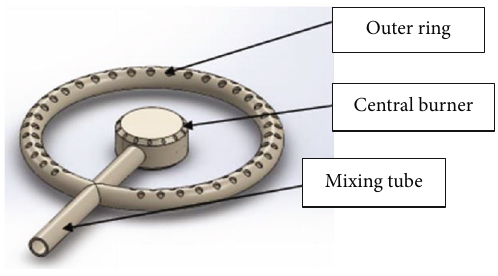
Figure 3: Biogas stove